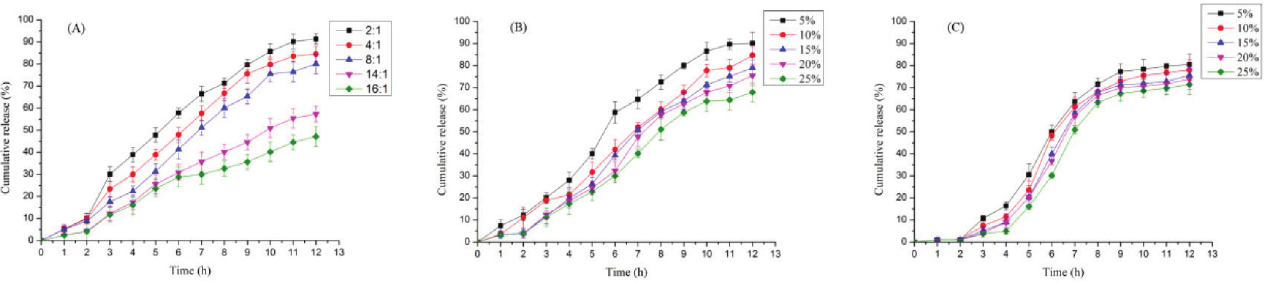
FIGURE 1 - The cumulative release of colon-specific pellets with (A) different ratios of Eudragit NE30D: Eudragit L30D55, (B) different weight gains of time-dependent layer, (C) different weight gains of pH-dependent layer. Data are presented as mean ± SD (n =